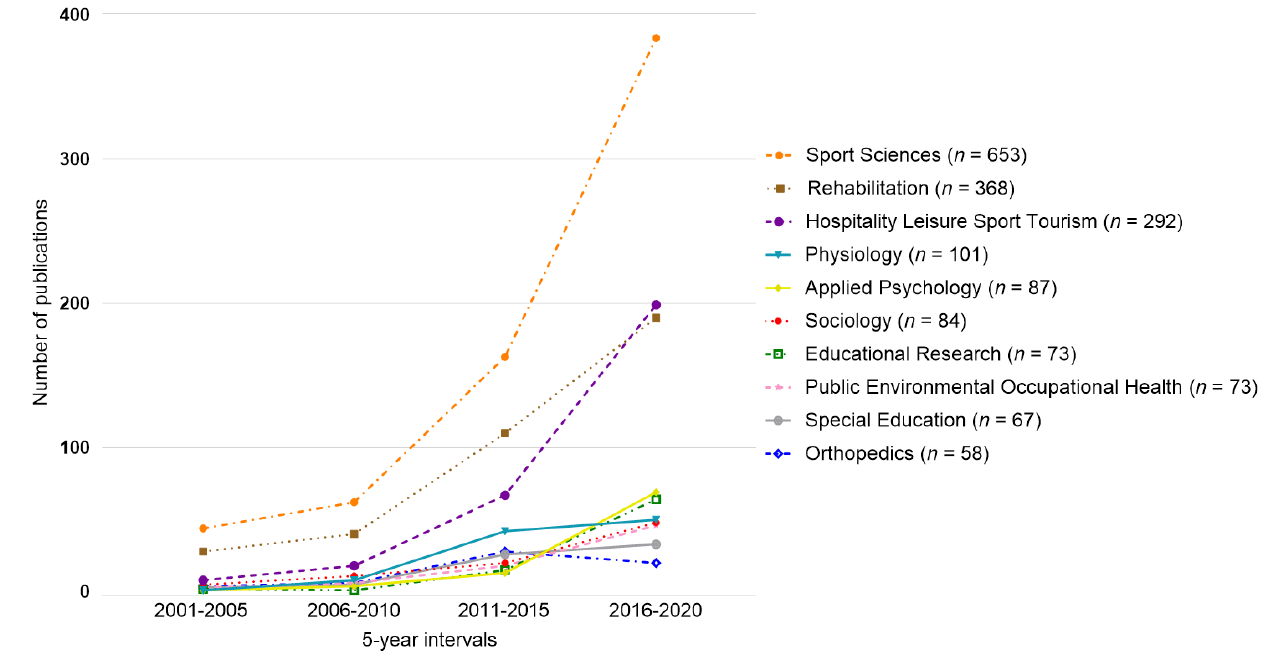
Figure 5. Major changes in the top 10 categories of adapted sport research.